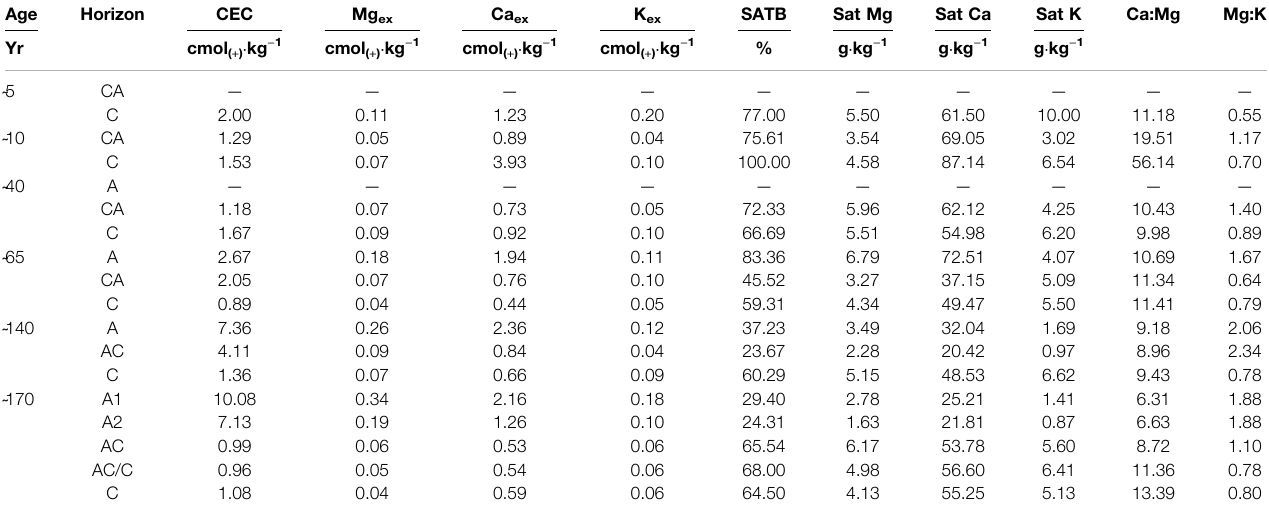
TABLE 3 | Cation-exchange capacity and base saturation of soil pits along the six stages of the chronosequence. CEC, cation-exchange capacity; Mg ex , magnesium exchangeable cations;